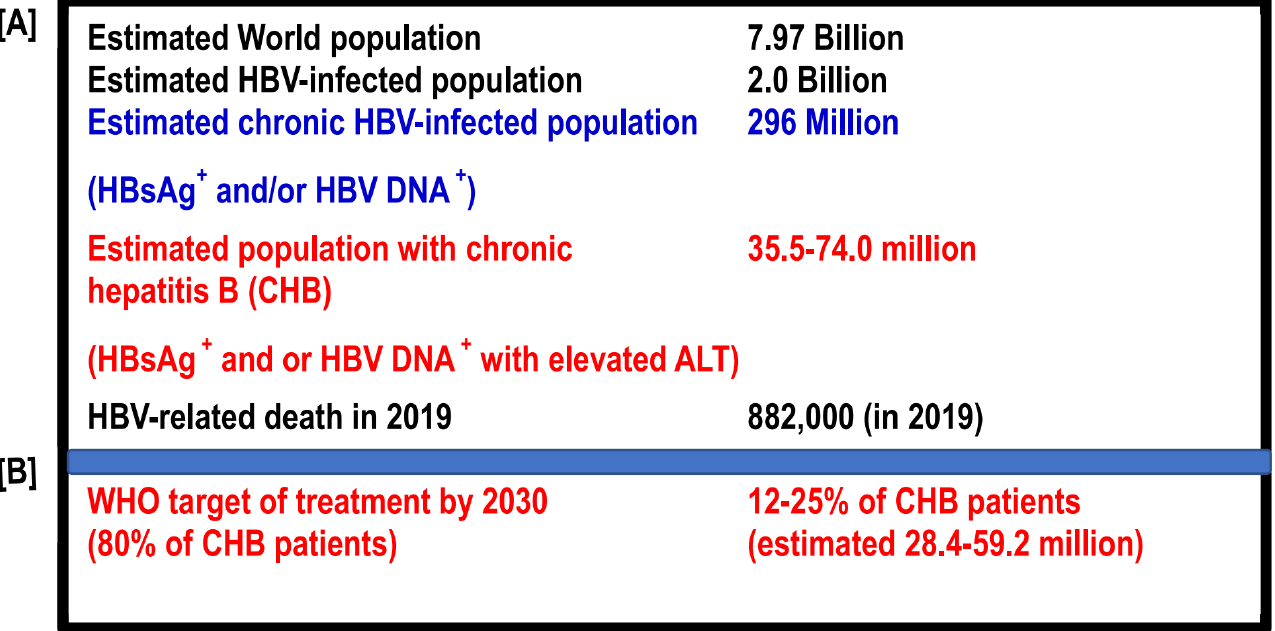
Figure 1. Spectrum of HBV infection in the world and targets of the World Health Organization to achieve “Elimination of Hepatitis by 2030” [8,9]. HBV, hepatitis B virus; CHB, chronic hepatitis B; HBsAg, hepatitis B surface antigen; ALT, alanine aminotransferase; WHO; World Health Organization.